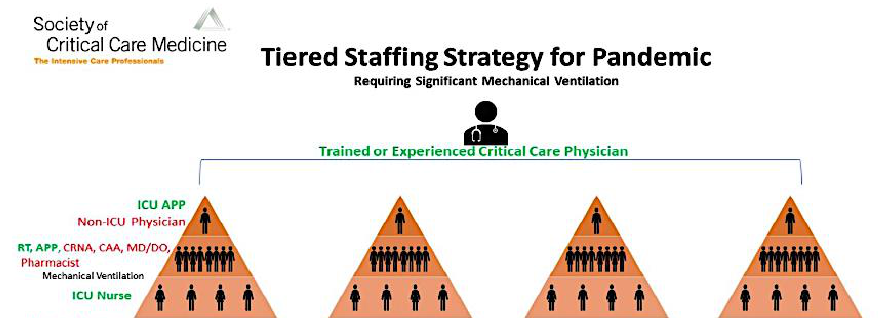
Figure 5. Model of ICU care teams.